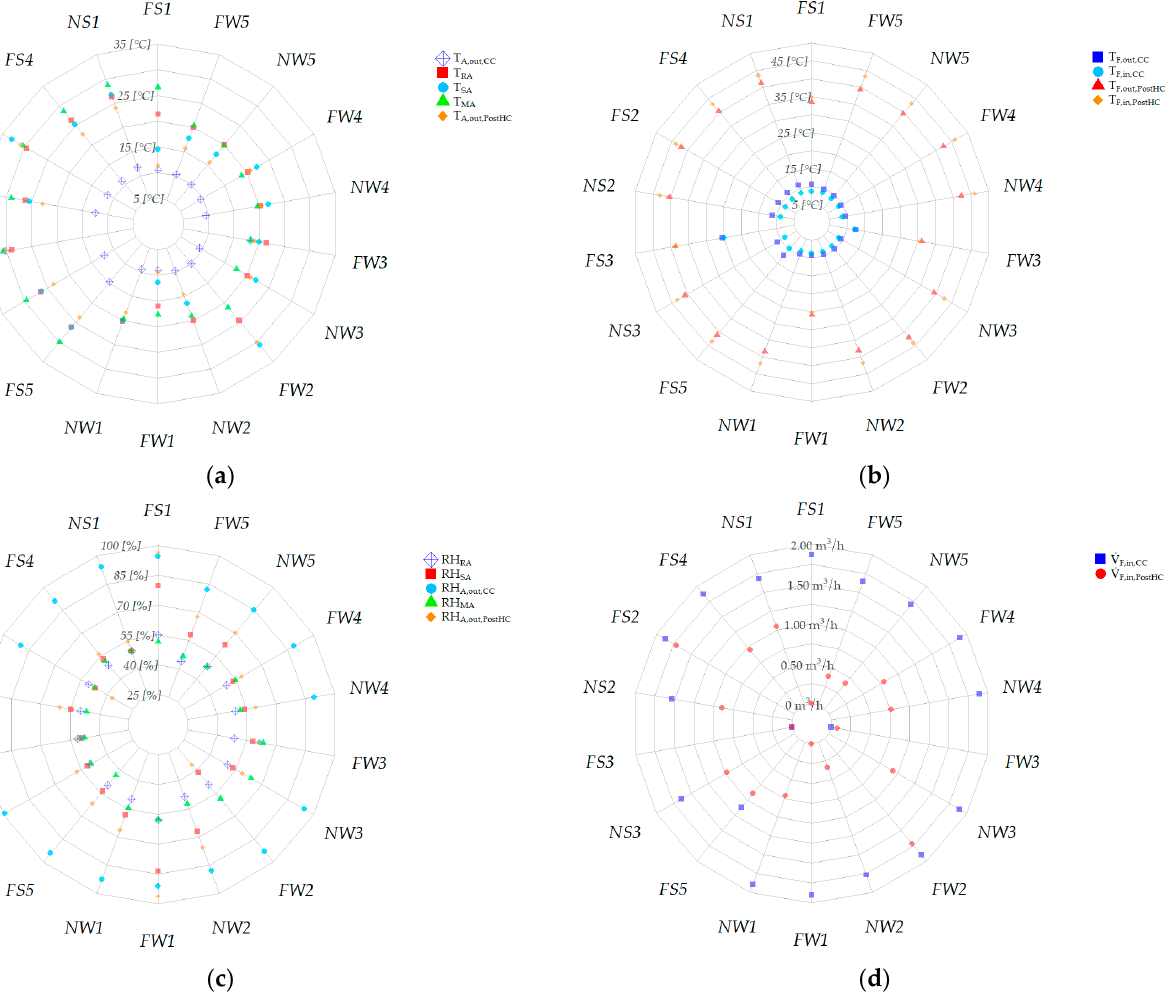
Figure 6. Arithmetic means of ( a ) air temperature, ( b ) water temperature, ( c ) air relative humidity, and ( d ) water volumetric flow rate measured during faulty and normal tests.